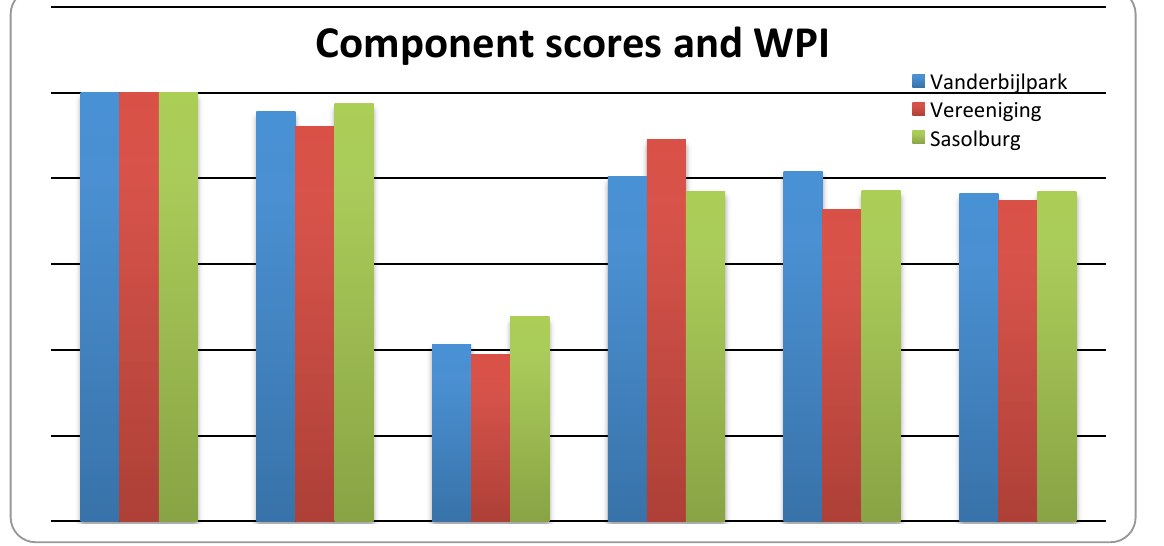
Figure 6 Graphical representation of component scores and